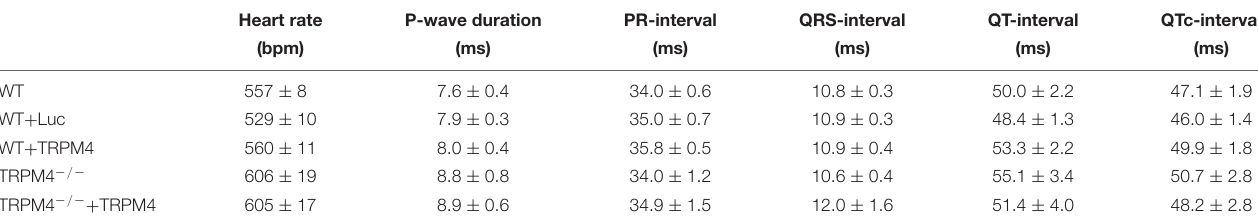
Heart rate P-wave duration PR-interval QRS-interval QT-interval QTc-interval